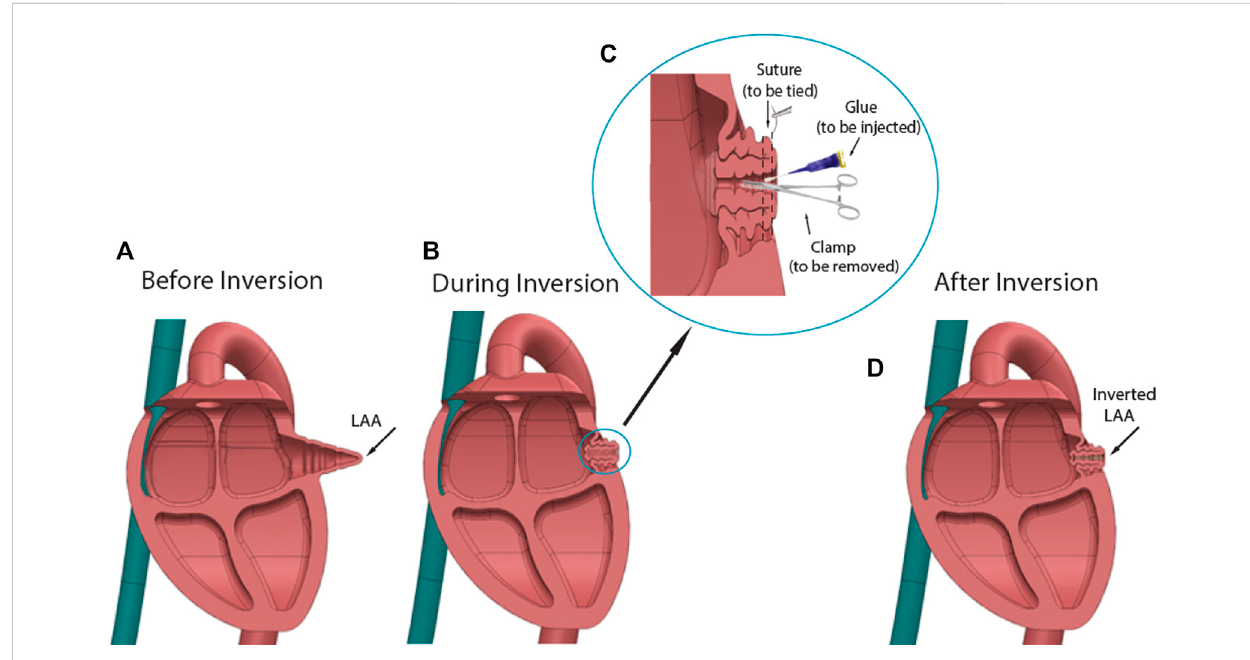
FIGURE 1 Diagram of LAA inversion procedure. (A) Shape of LAA before inversion. (B) Using surgical tools and glue to invert the LAA apex. (C) . Procedure details:AnauricleclampgentlygrabbedtheLAAapexandputitinward,whiletissuegluewasappliedaroundthetipofclamp.Thepurse-stringsuturewas knotted to secure the inversion. (D) Shape of inverted LAA. The procedure reduced the dead space in the LAA chamber.